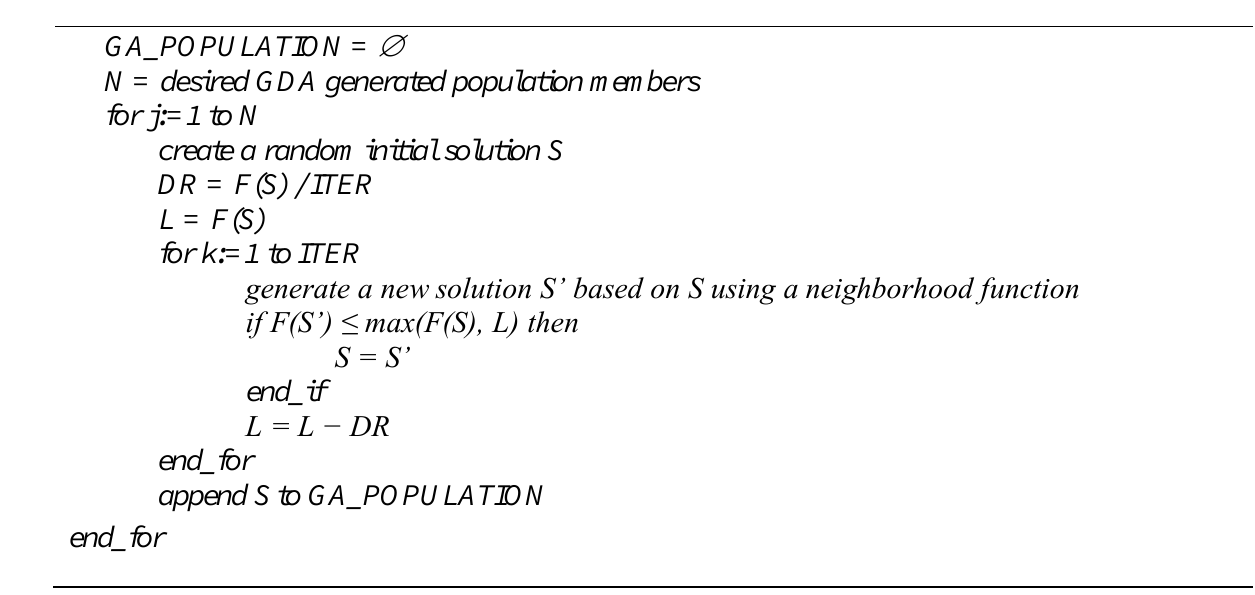
Algorithm 1.: Great Deluge Algorithm for initial population generation.